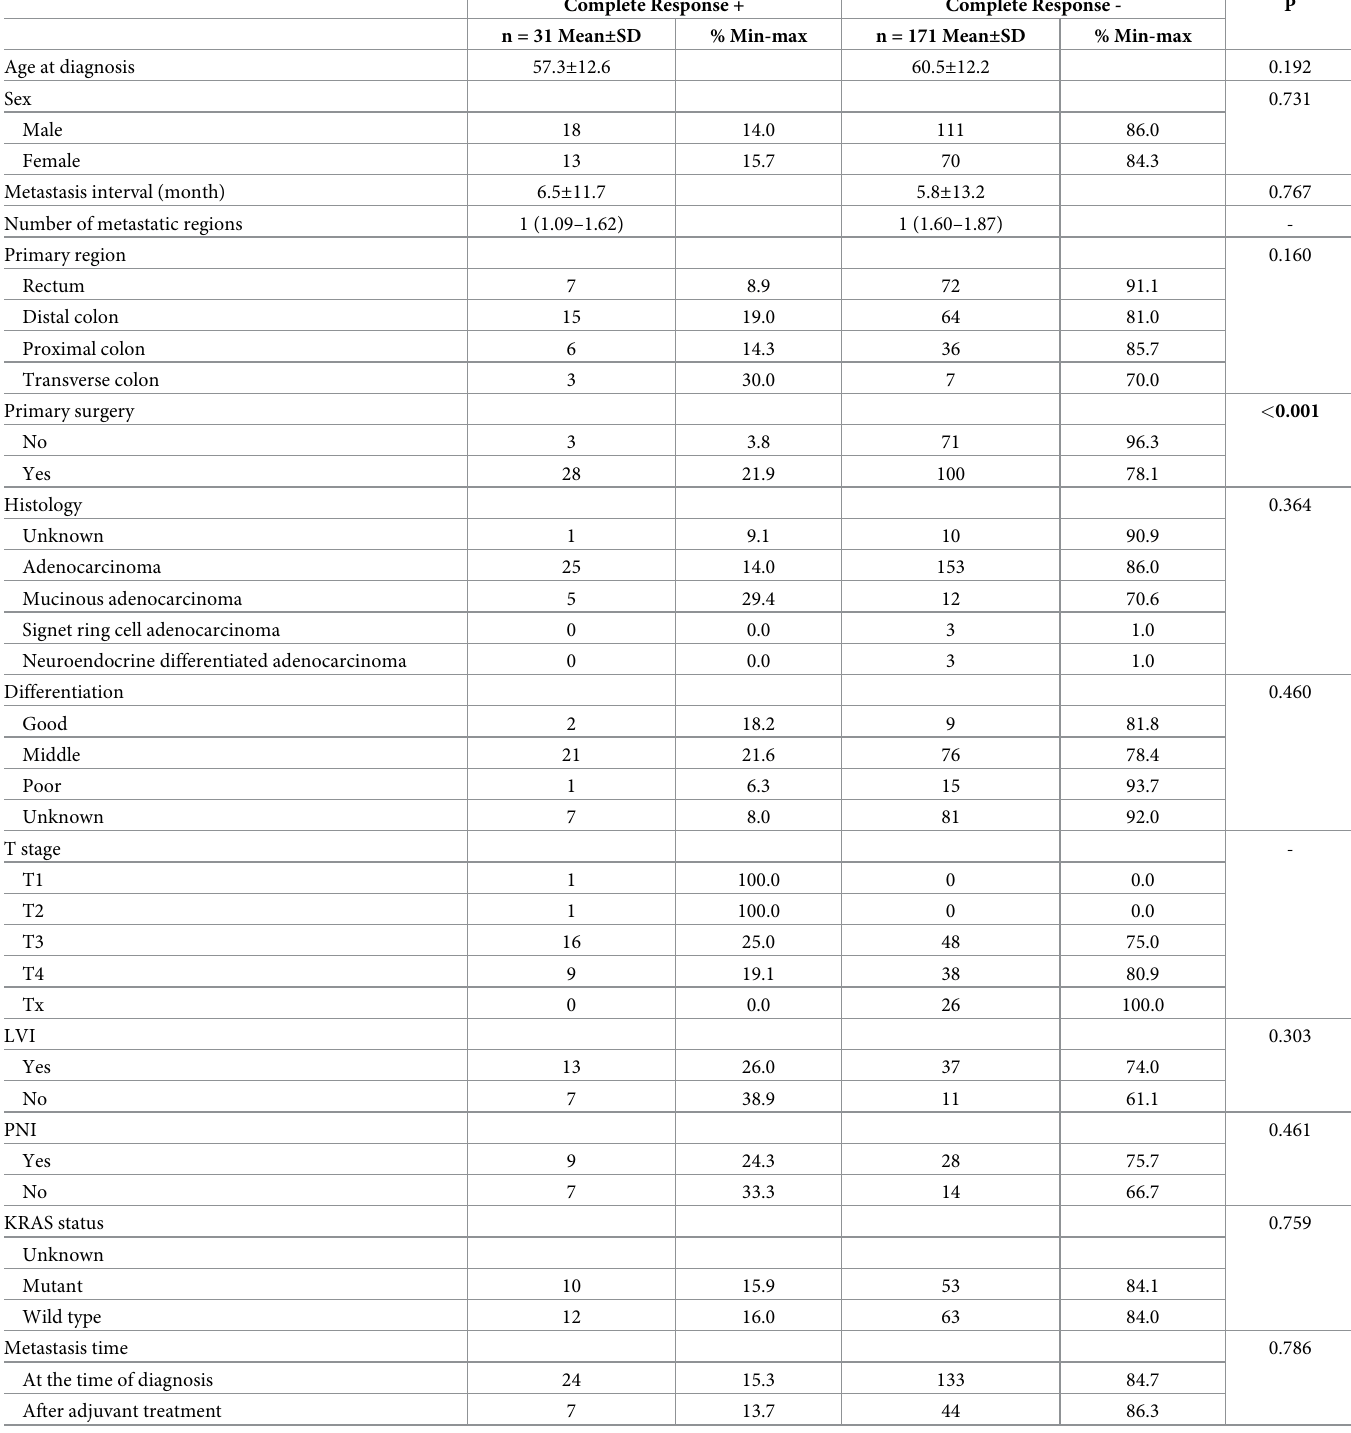
Table 1. The comparison of clinical and histopathologic findings according to the complete response to